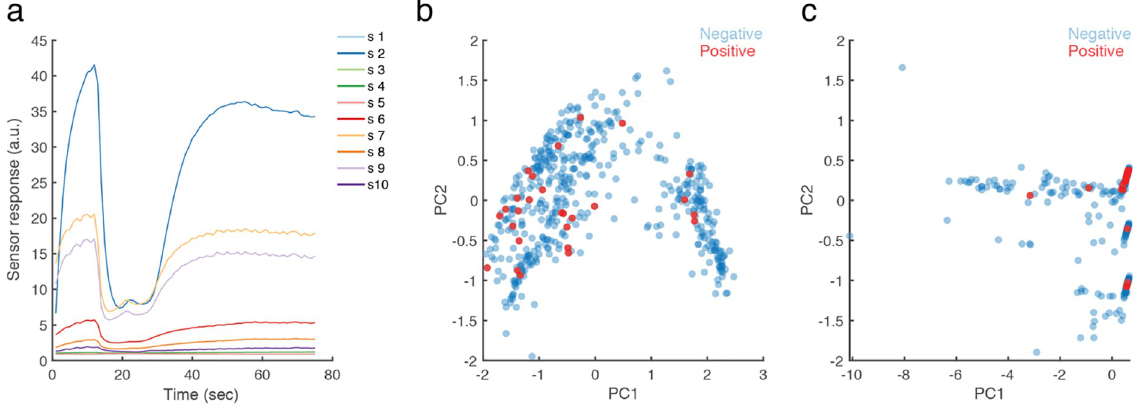
Fig 4. eNose measurements cluster SARS CoV-2 positive participants. A . An example of the raw eNose measurement from one participant. Each line is one of 10 sensors. B . PCA of the equilibrium end-values only. C . PCA of the 3rd degree polynomial fit of the entire time-series. n = 503. The 27 positive samples are in